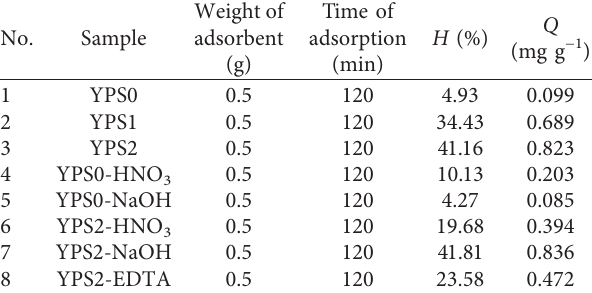
Table 3: Cr (VI) ion adsorption ability of YPS samples.